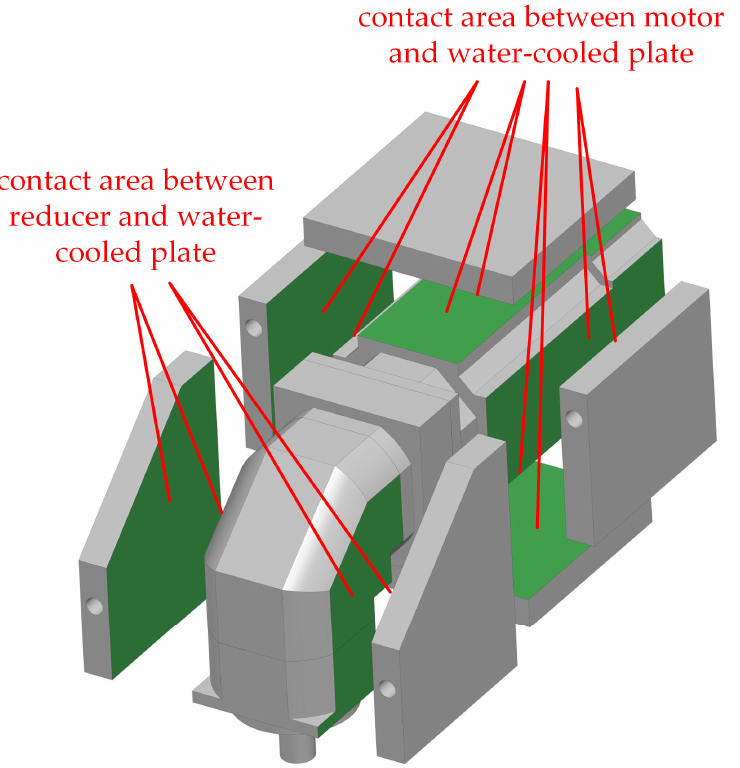
Figure 2. Heat-exchange contact surface.